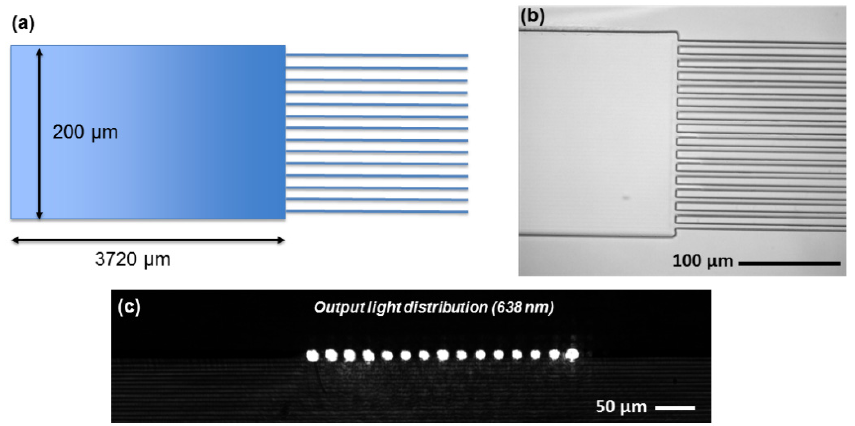
Figure 11. A 1 × 15 MMI sol-gel coupler obtained by direct laser writing technique. ( a ) Overview of the splitter. ( b ) Corresponding microscopic image and ( c ) output light at 638 nm under excitation with an SMF28. The coupler corresponds to a 200 µm × 3720 µm rectangular structure.